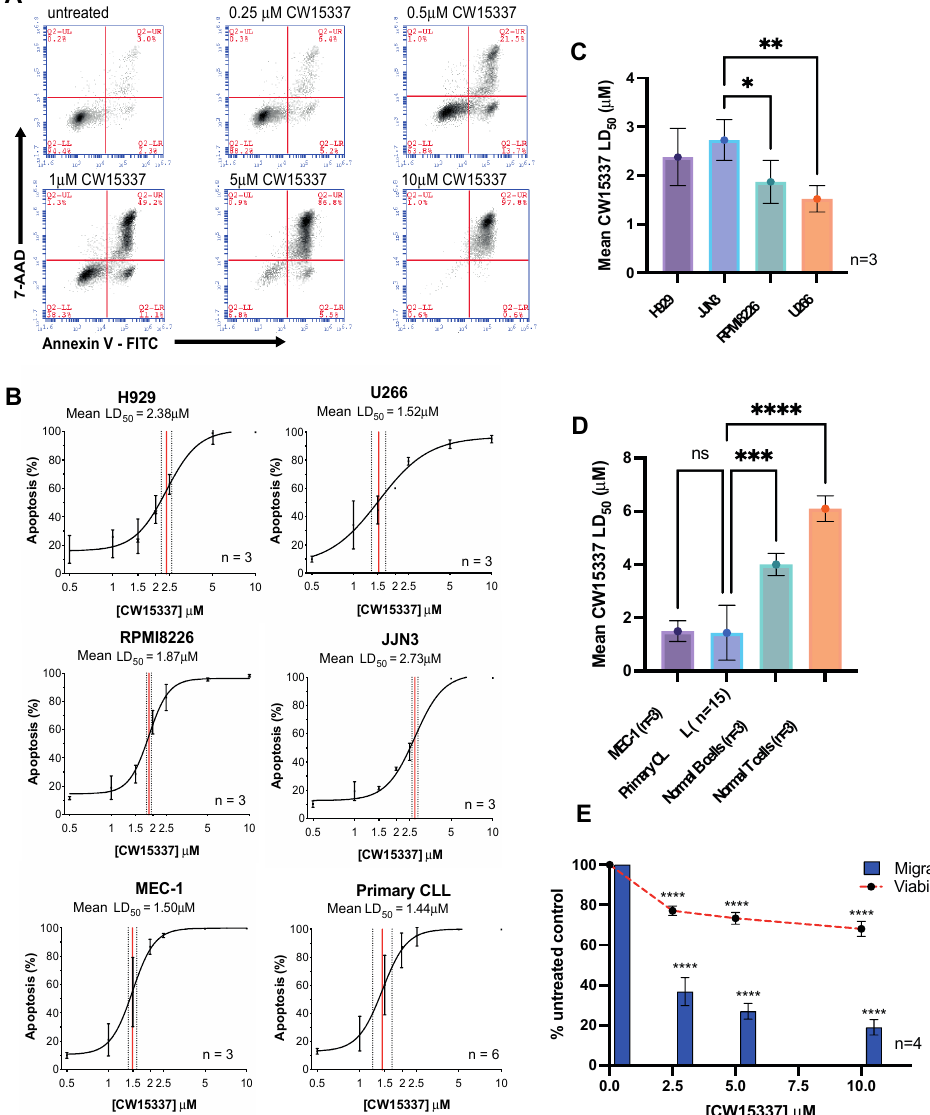
Figure 1. Primary CLL cells and CLL and myeloma cell lines are all susceptible to NF- κ B-inducing kinase (NIK) inhibition. ( A ) An example of Annexin V and 7-AAD bivariate plots obtained from primary CLL cells treated with increasing concentrations of CW15337. A concentration-dependent increase in the proportion of Annexin V + /7-AAD − and Annexin V + /7-AAD + was observed. ( B ) Sig- moidal dose–response curves illustrating the comparative effects of CW15337 on the H929, U266, RPMI8226, JJN3, MEC-1 cell lines and primary CLL cells. ( C ) Comparative analysis of the mean LD 50 values for CW15337 in the four multiple myeloma cell lines revealed heterogeneous sensitivity to the effects of CW15337 between the cell lines. ( D ) CW15337 was significantly more potent in MEC-1 cells and primary CLL cells when compared with normal B- and T-lymphocytes. ( E ) CW15337 inhibited the migration of MEC-1 cells in a concentration-dependent manner. **** p < 0.0001, *** p < 0.001, ** p < 0.01 and * p < 0.05. ns = not significant.